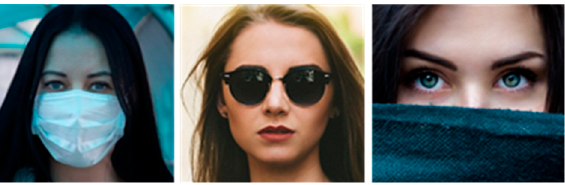
Figure 1. Cases of occlusion on the face due to various factors.